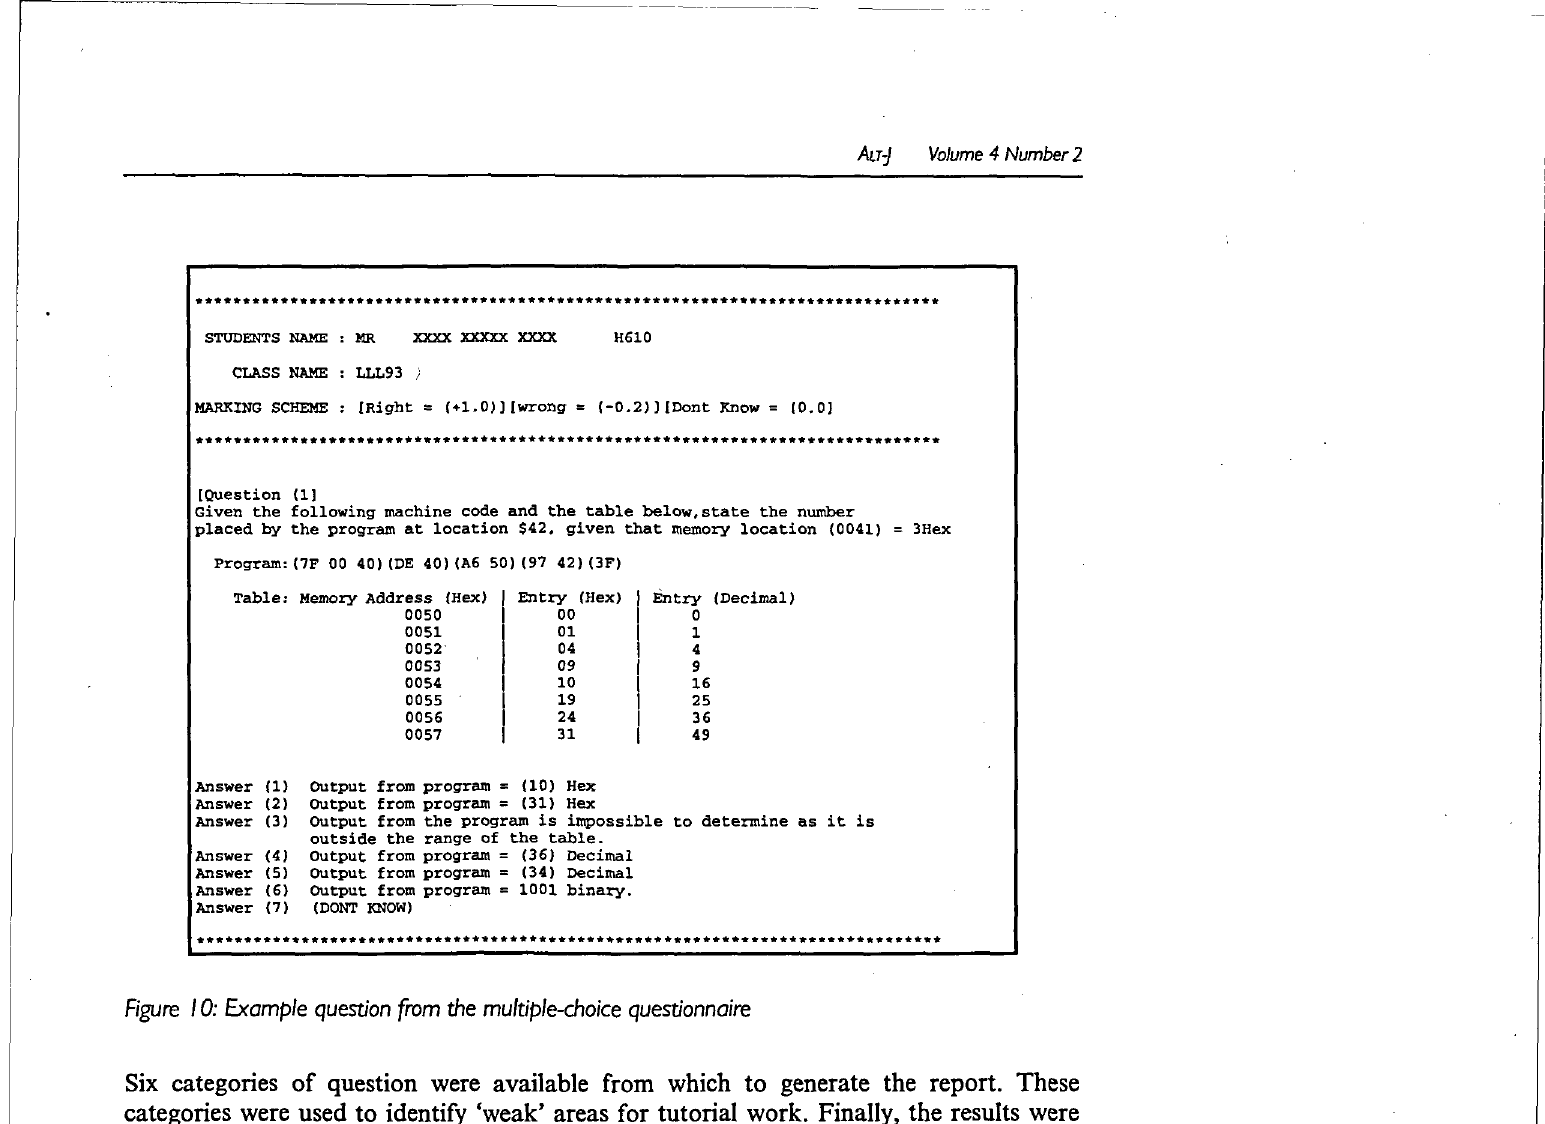
figure / 0: Example question from the multiple-choice questionnaire Six categories of question were available from which to generate the report. These categories were used to identify 'weak' areas for tutorial work. Finally, the results were correlated with those previously obtained from a traditional examination, and they produced a correlation coefficient of 0.923 for 111 degrees of freedom and two